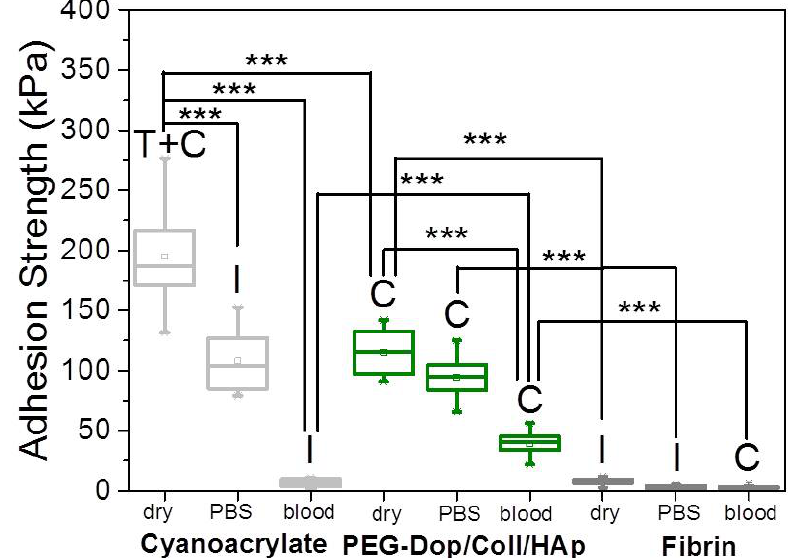
Figure 4. Adhesion strength values of PEG-Dop adhesives on “dry” skin, and “wet” skin (either with phosphate-buffered saline (PBS) or with blood) compared with commercial tissue glues. Failure type: I, interfacial; C, cohesive; T + C, mixture of tissue and cohesive. *** p <